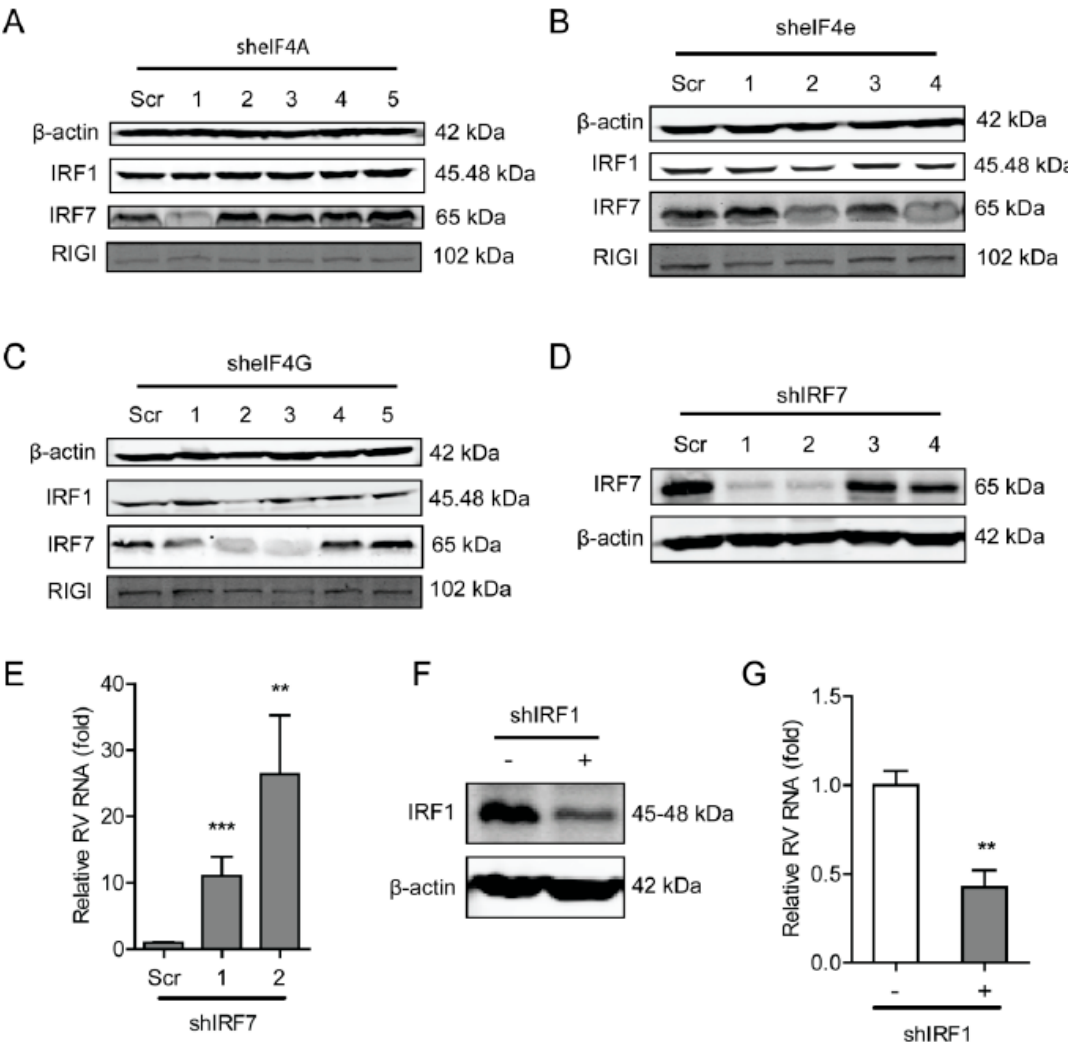
Figure 6. The eIF4F complex is required for IRF7 that exerts anti-rotavirus effect. ( A ) Western blot assay detected the protein level of antiviral factors including IRF1, IRF7, and RIG-I in eIF4A knockdown Caco2 cells. ( B ) Western blot assay detected the protein level of antiviral factors including IRF1, IRF7, and RIG-I in eIF4E knockdown Caco2 cells. ( C ) Western blot assay detected the protein level of antiviral factors including IRF1, IRF7, and RIG-I in eIF4G knockdown Caco2 cells. ( D ) Western blot assay detected the protein level of IRF7 in eIF4G knockout Caco2 cells, and two out of four shRNA vectors showed successful knockdown of IRF7 detected by western blot. ( E ) Silence of IRF7 increased rotavirus genomic RNA level detected by qPCR assay ( n = 6, ** P < 0.01, *** P < 0.001, Mann–Whitney test). ( F ) Western blot assay detected the protein level of IRF7 in eIF4G knockout Caco2 cells, indicating the successful knockdown of IRF1 detected by western blot. ( G ) Silence of IRF1 increased the rotavirus genomic RNA level detected by qPCR assay ( n = 6, ** P < 0.01, Mann–Whitney test).